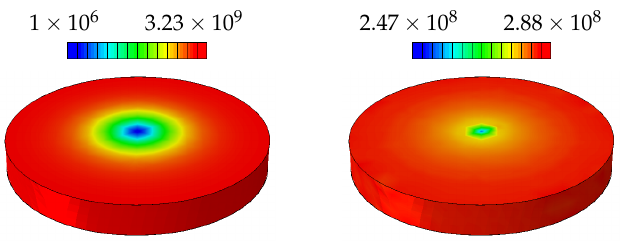
Figure 10. Distribution of the final SSDs ( left ) and GNDs ( right ) [ mm − 2 ] for the disc with r = 10 µ m, as a result of the applied